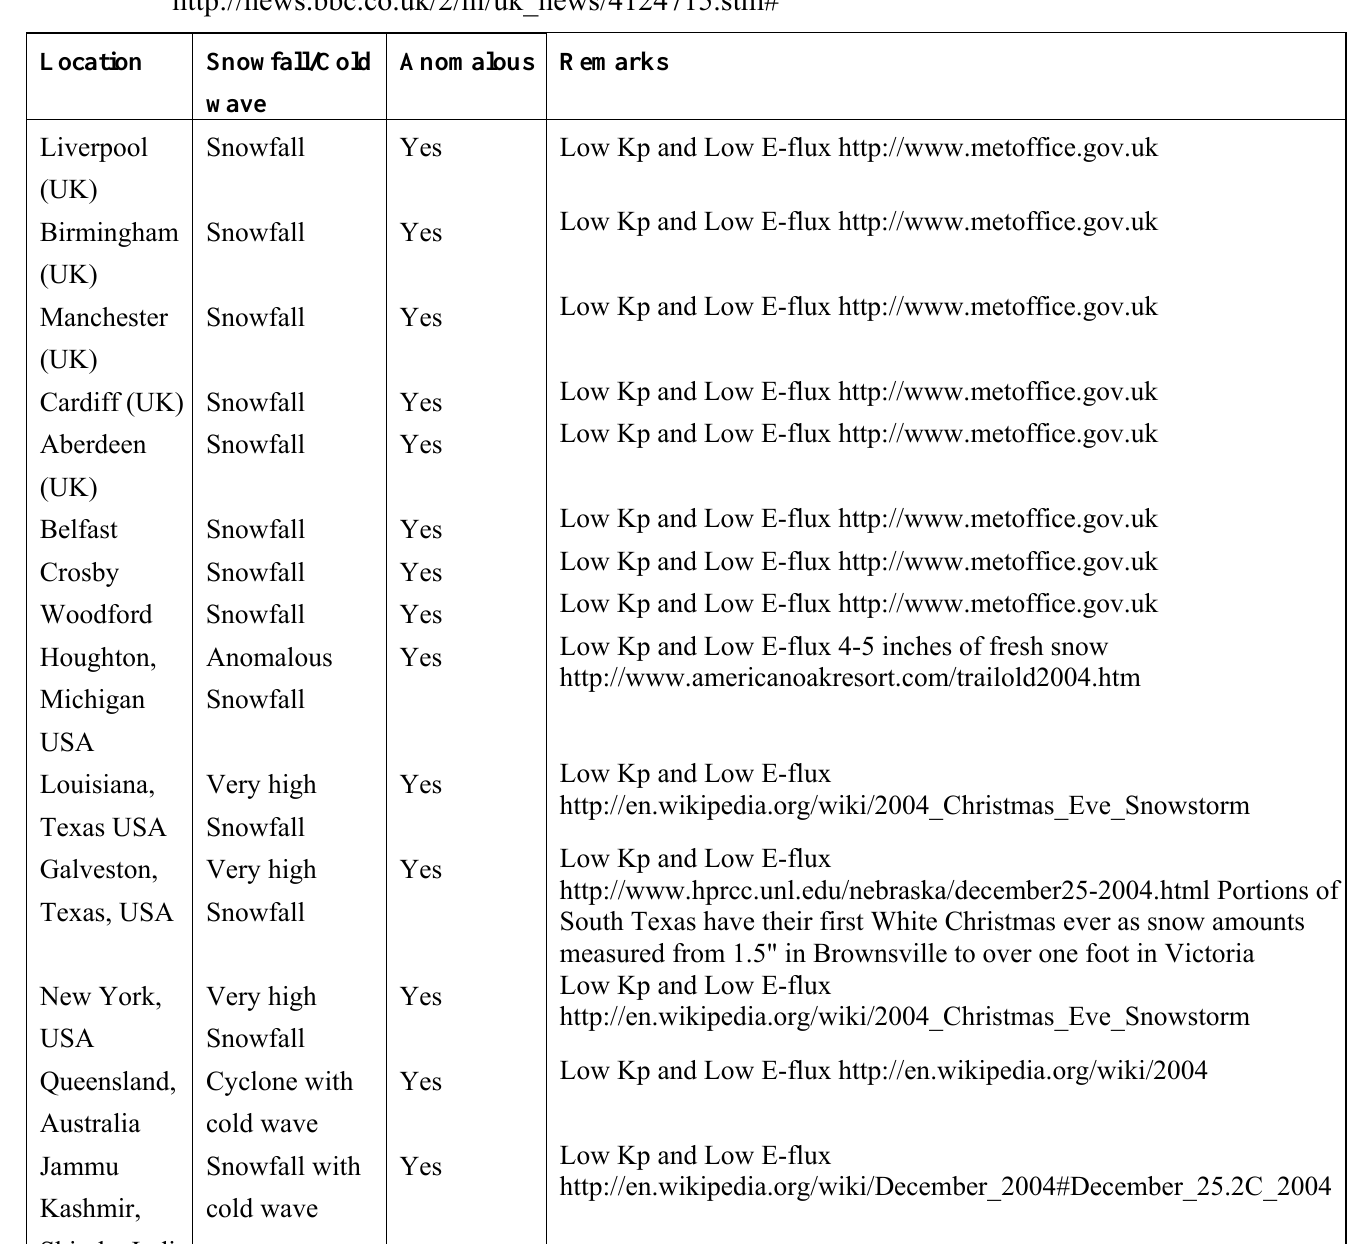
Table 1. Sudden snowfall and rainfall after the rise in temperature in higher altitude and latitude on 25th December 2004 before the tsunami and earthquake in Indonesia. This observation has been recorded across the world including Europe, Asia and